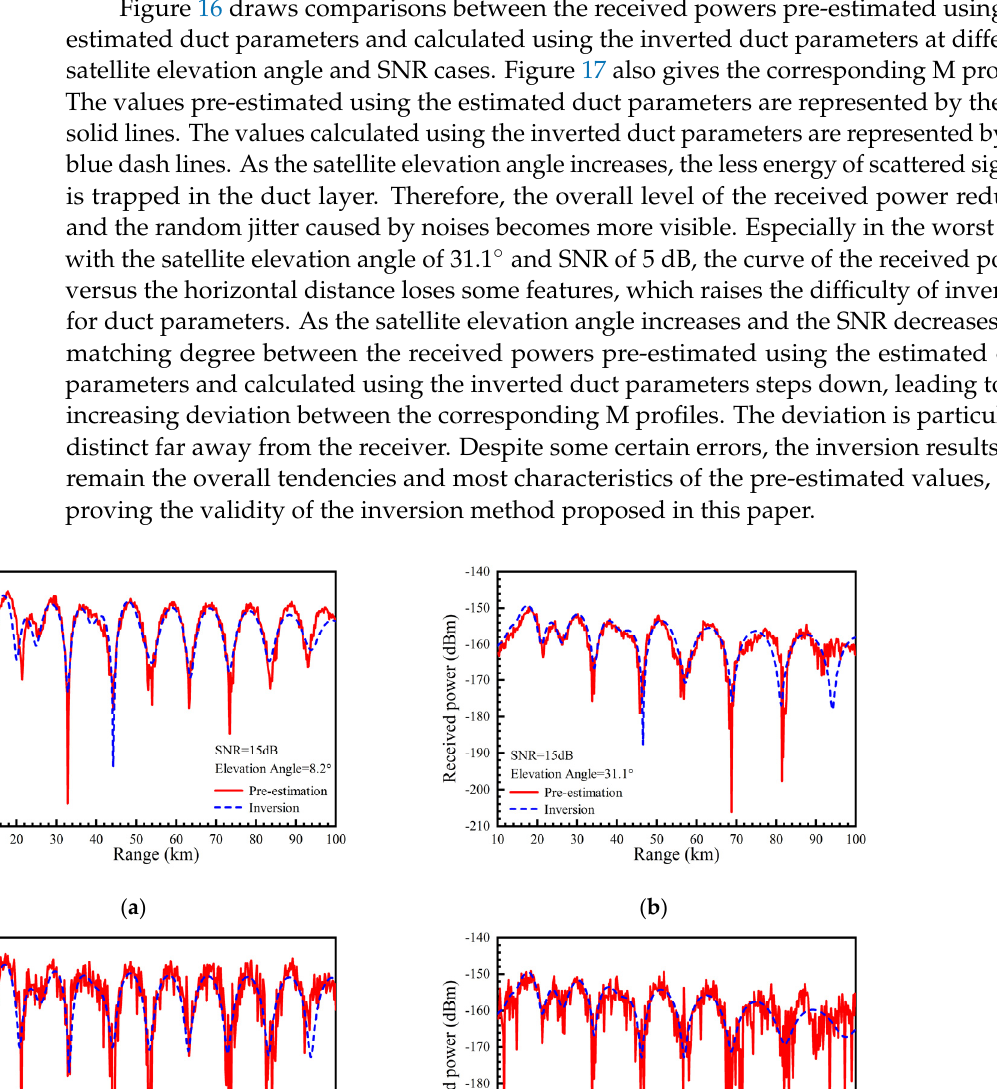
( d ) Figure 17. The M profiles pre-estimated using the estimated duct parameters and calculated using the inverted duct pa- rameters at different satellite elevation angle and SNR cases: ( a ) the satellite elevation angle is 8.2° and the SNR is 15 dB; ( b ) the satellite elevation angle is 31.1° and the SNR is 15 dB; ( c ) the satellite elevation angle is 8.2° and the SNR is 5 dB; and ( d ) the satellite elevation angle is 31.1° and the SNR is 5 dB.